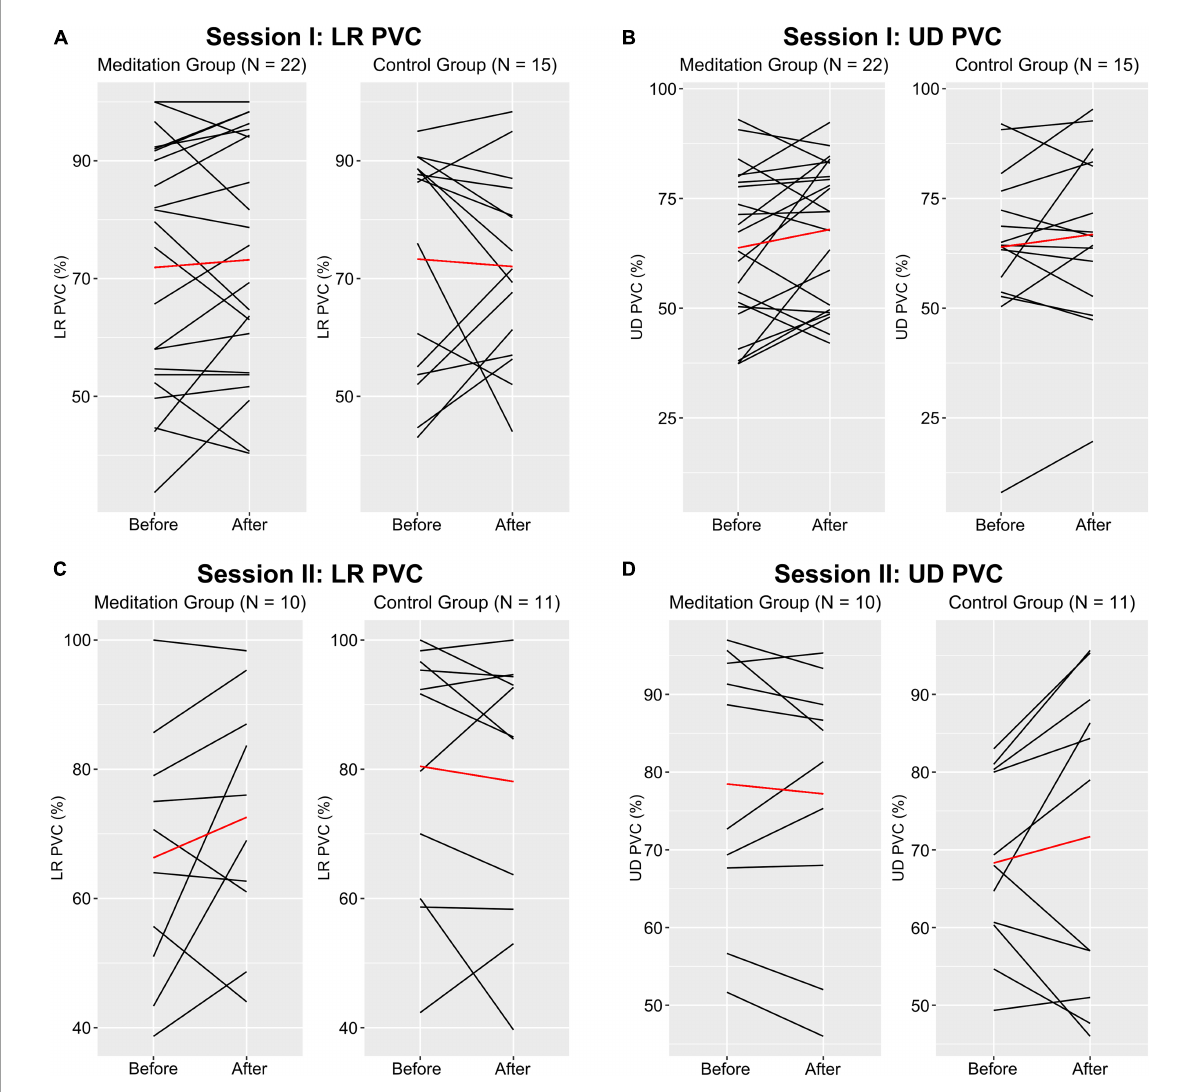
FIGURE3 Line graphs of each subject’s performance in the LR and UD tasks in both sessions. Black lines represent each subject’s average LR and UD PVC before and after each intervention and the red lines represent the group average PVC. (A) Change in LR PVC for meditation group (group MM and group MC) and control group (group CM) from session 1. (B) Change in UD PVC for meditation group and control group from session 1. (C) Change in LR PVC for meditation group and control group from session 2. (D) Change in UD PVC for meditation group (group MM) and control group (group MC) from session